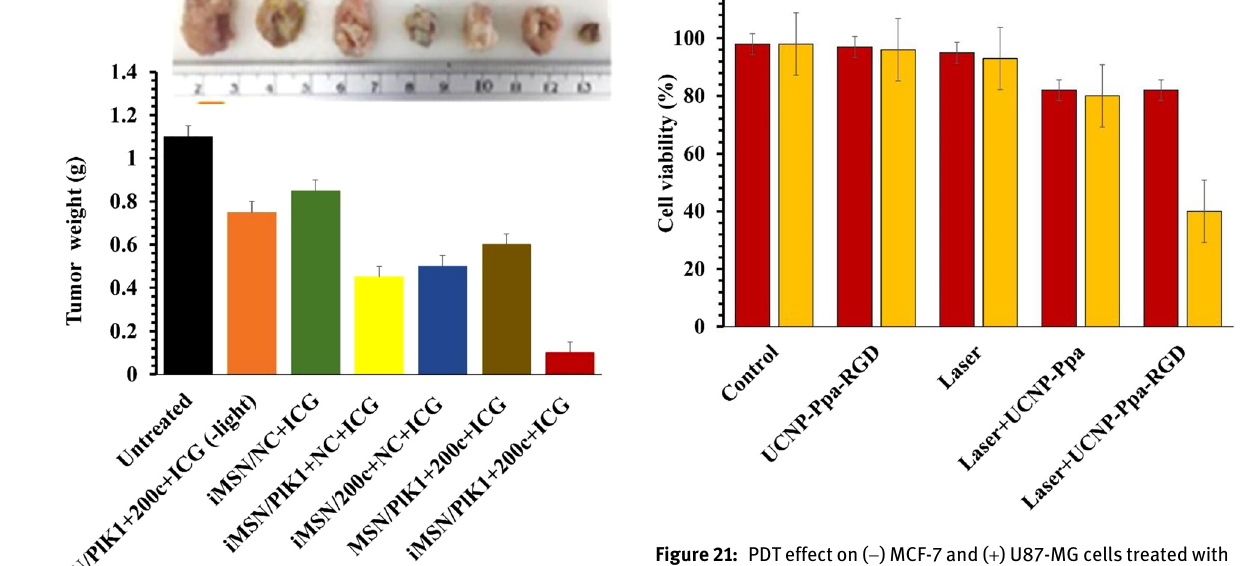
Figure 21: PDT effect on ( − ) MCF-7 and ( + ) U87-MG cells treated with different concentration of 0, 50, 100, 200 μ g/mL NPs (980 nm, 500 mW cm − 2 for 5 min). Adapted from Zhou et al.